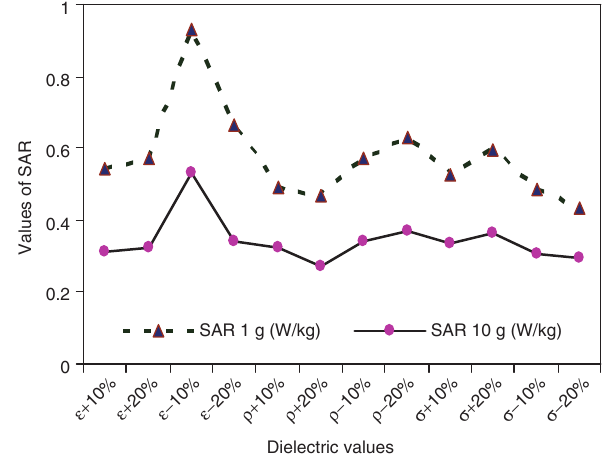
Figure 1 Deviation of the peak of unaveraged SAR in different dielectric properties of Rogers R03006 (loss free) substrate at 1800 MHz.